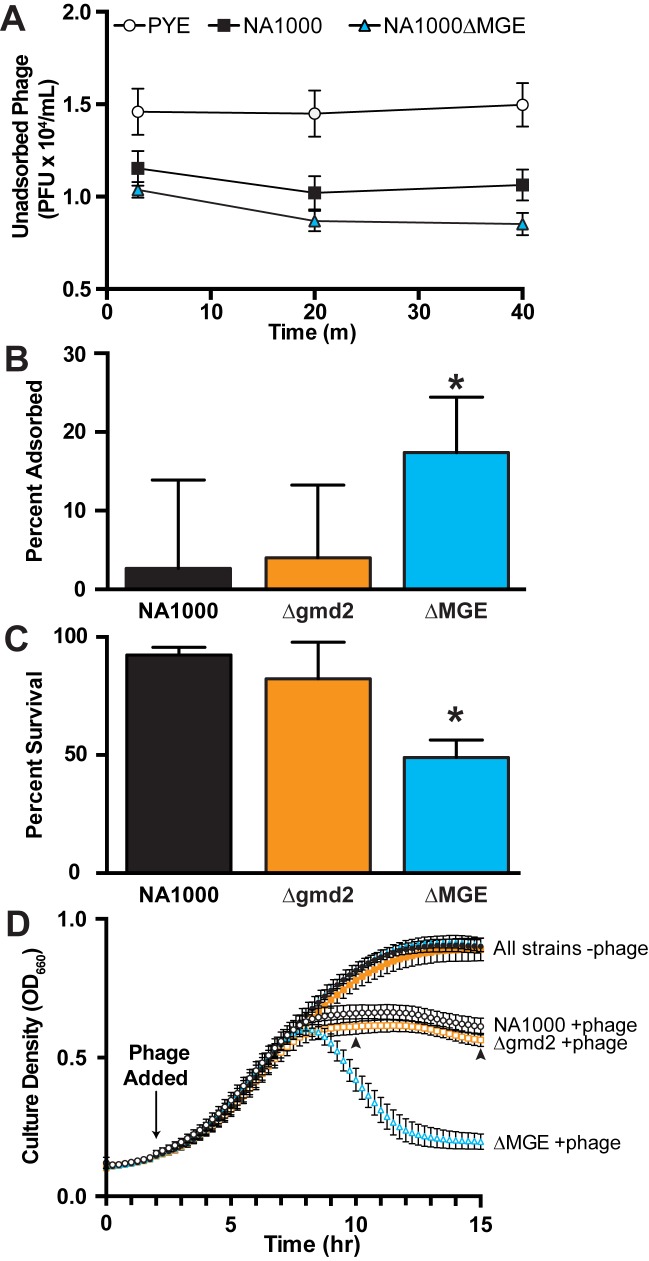
C. crescentus EPS inhibits binding and provides partial resistance to bacteriophage CR30.(A) Cultures of NA1000ΔMGE adsorb more phage CR30 than NA1000. In a timecourse experiment where phage CR30 was added to C. crescentus cultures, sampled immediately (60–90 seconds), at 20 minutes, and at 40 minutes. Unadsorbed phage were quantified. Both samples containing C.crescentus cells adsorbed phage quickly and show significantly fewer remaining plaque forming units in the lysate (NA1000, black squares and NA1000ΔMGE, blue triangles) relative to the control (PYE, open circle). Throughout the experiment, EPS- (NA1000ΔMGE) cells continue to adsorb more phage than EPS+ (NA1000) cells. (B) The presence of EPS on cellular surfaces reduces phage CR30 adsorption. Adsorption experiments were carried out as in (A) and percent adsorption was measured as the concentration of viable plaque forming units present in the sample at 40 minutes relative to the number present at the initial sampling point. EPS+ (NA1000, black bar) and intermediate EPS (NA1000Δgmd2, orange bar) cells adsorb fewer phage after 40 minutes, than EPS- (NA1000ΔMGE blue bar) cells (ANOVA F(2, 42) = 3.506, P = 0.0391, NA1000 vs. NA1000ΔMGE t(42) = 2.395, p = 0.0423, NA1000 vs. NA1000Δgmd2 t(42) = 0.2207, p > 0.9999). (C) Survival is lower in strains that adsorb more phage. Cultures of EPS+, intermediate, or EPS- cells (NA1000, NA1000Δgmd2, or NA1000ΔMGE, respectively) were challenged with phage CR30, and incubated for 18 hours. Cell density (OD660) was compared with no phage controls (ANOVA F(2, 61) = 45.79, p < 0.0001, NA1000 vs. NA1000ΔMGE t(61) = 9.288, p < 0.0001, NA1000 vs. NA1000Δgmd2 F(2, 61) = 1.708, p = 0.1855). (D) The dynamics of population response phage to CR30 infection are influenced by EPS phenotype. As expected, all strains tested showed some susceptibility to phage CR30 and do not grow to the same density as phage-free cultures. As seen in previous experiments, (A-C), the presence of EPS is largely protective against phage CR30 infection. With larger sample sizes in this high throughput assay, we measured a small increase in phage CR30 susceptibility in NA1000Δgmd2 relative to NA1000 (at 10 hours: t(66) 2.357, p = 0.0214; at 15 hours: t(66) = 2.582, p = 0.0121, indicated with arrowheads).